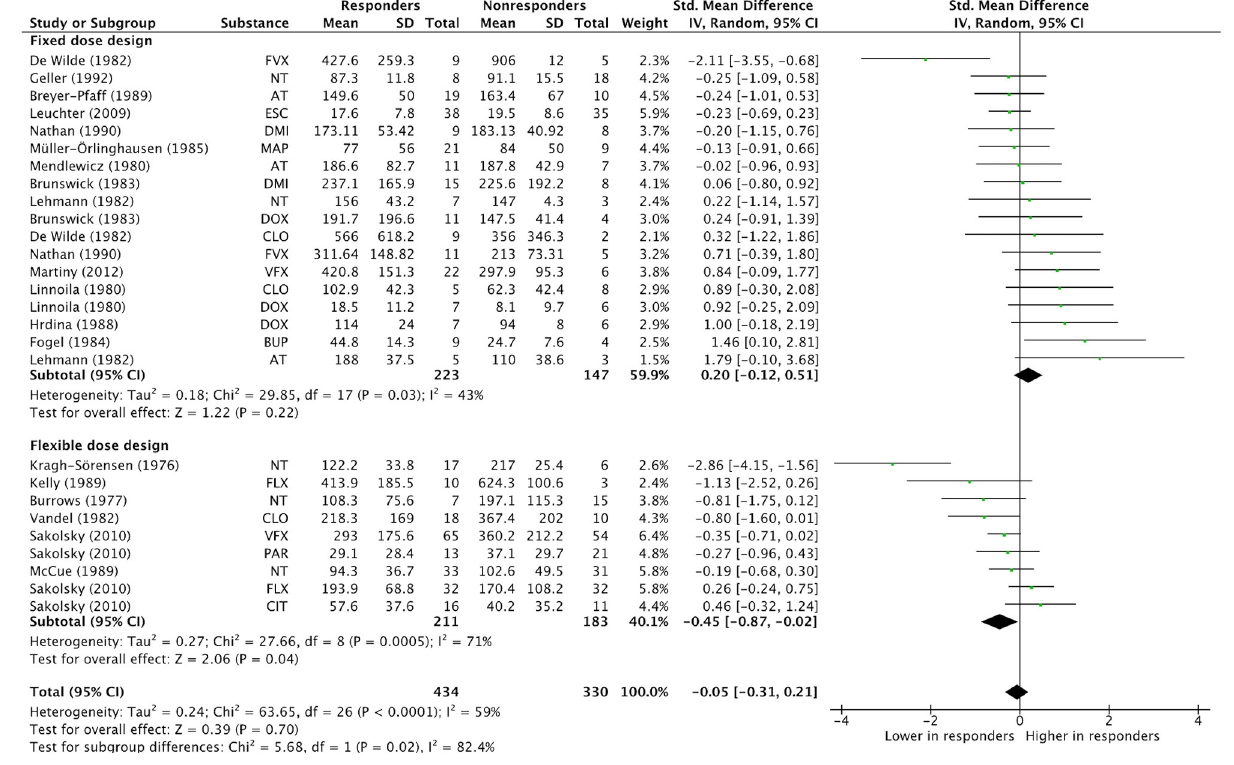
FIGURE 3 | Subgroup analysis “Dose design”. Overall effect estimates across N treatment arms = 27, in N = 19 studies. AT, Amitriptyline; BUP, Bupropion; CIT, Citalopram; CLO, Clomipramine; DMI, Desipramine; DOX, Doxepin; ESC, Escitalopram; FLX, Fluoxetine; FVX, Fluvoxamine; MAP, Maprotiline; NT, Nortriptyline; PAR, Paroxetine; VFX,